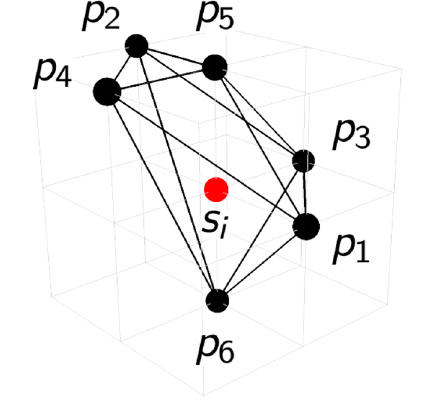
Figure 27 . Toric diagram for Model